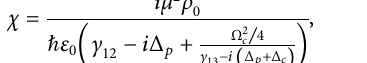
Frontiers in Physics |